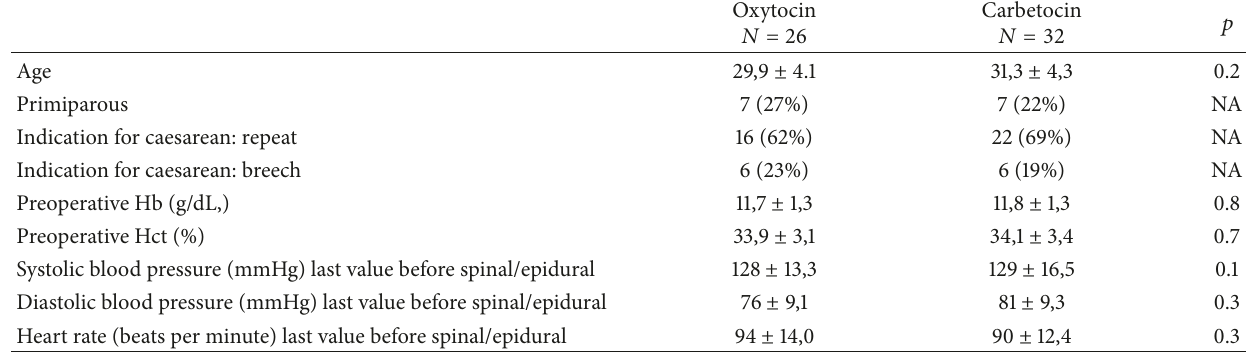
Figure 1: Flow chart of inclusions. Table 1: Patient characteristics.